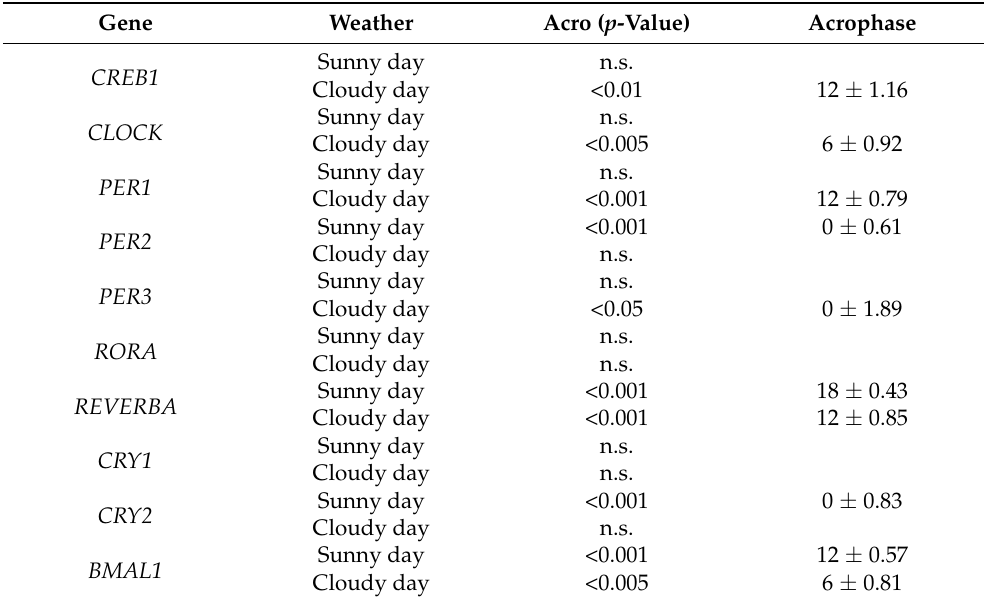
Table 3. Cosinor analysis board for rhythm gene expression under sunny and cloudy conditions. Gene